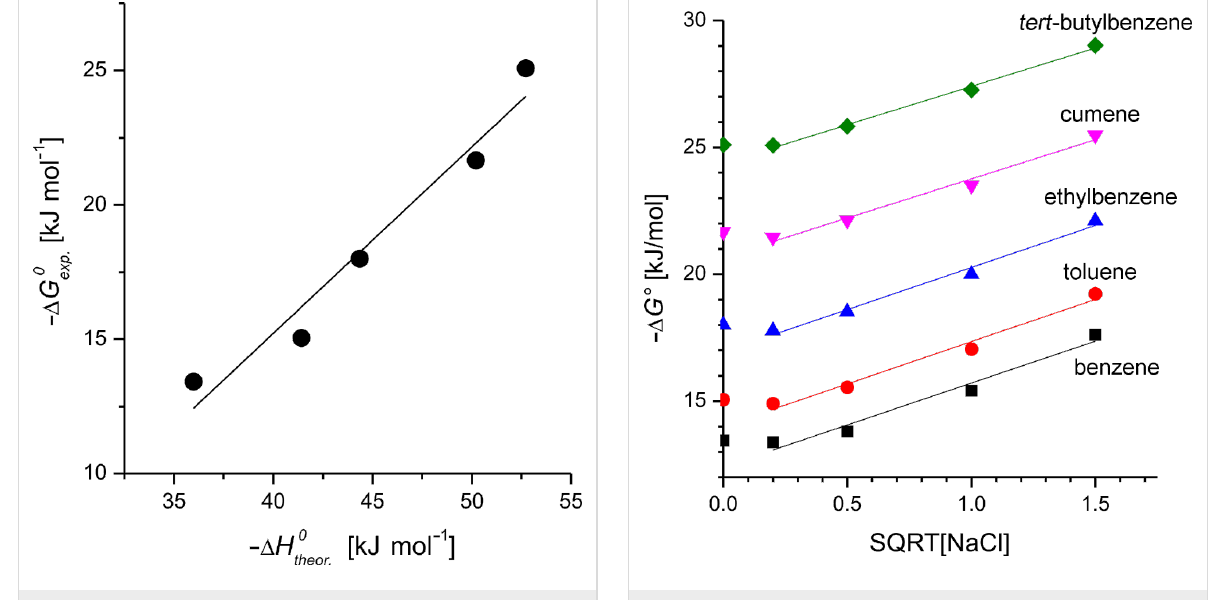
Figure 6: Gibbs free energy of formation of the inclusion compounds of benzene derivatives in host 4 as a function of the theoretical inclu- sion enthalpy, obtained by simulation by Macromodel (slope 0.69).